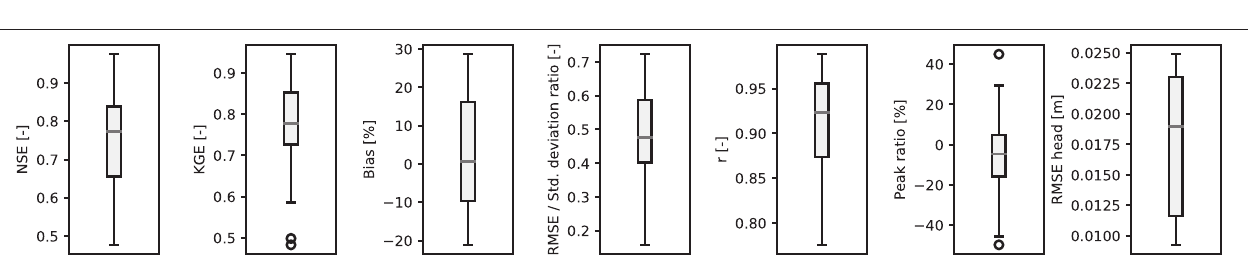
FIGURE 8 | Box plots computed for all experiments considered in model validation including the following list of criteria: Nash-Sutcliffe Model efficiency (NSE), Kling Gupta efficiency (KGE), Percentage volume Bias, RMSE to Standard deviation ratio computed for runoff (RSR), Pearson correlation (r), RMSE for water level, as well as peak runoff